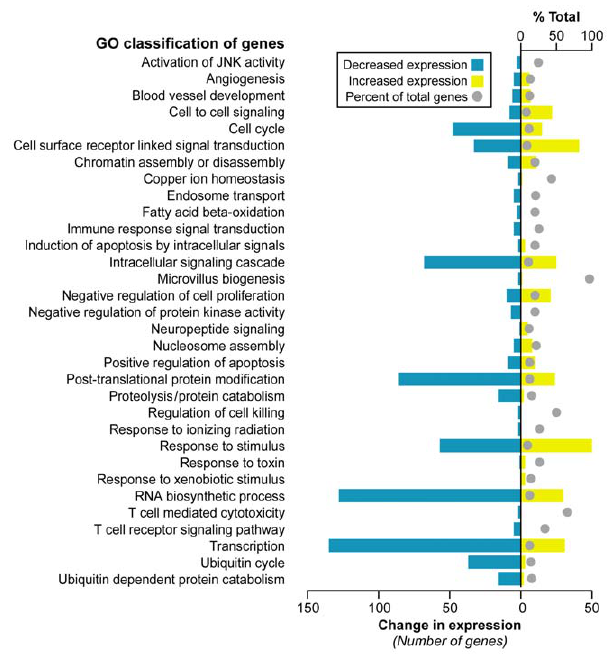
Figure 1. Selected gene classifications according to biological processes. Significantly regulated genes (SAM FDR , 0.023%; n=1,370) from FRDA children versus healthy youngadults were grouped according to the gene ontology category of biological process ( p # 0.05 in updown , over , or under [expression] output lists). The percent of total (displayed with a gray ball) is based on the number of significantly changed genes out of the total number of genes assigned to each gene ontology term. The change in expression for each GO term is depicted in yellow for upregulation and blue for downregulation.